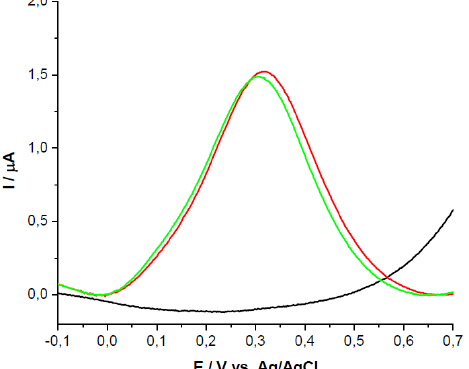
Figure 9. SWVs for: 215.26 µM AA solutions in the absence (red) and in the presence of 116 µM sodium metabisulphite (green) compared with the electrolyte (0.1 M PB; pH 7.2) (black).